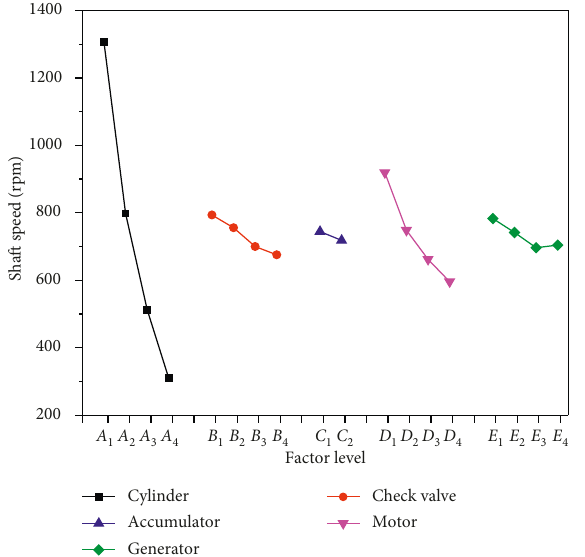
Figure 8: The index level of regenerated power at different factors.